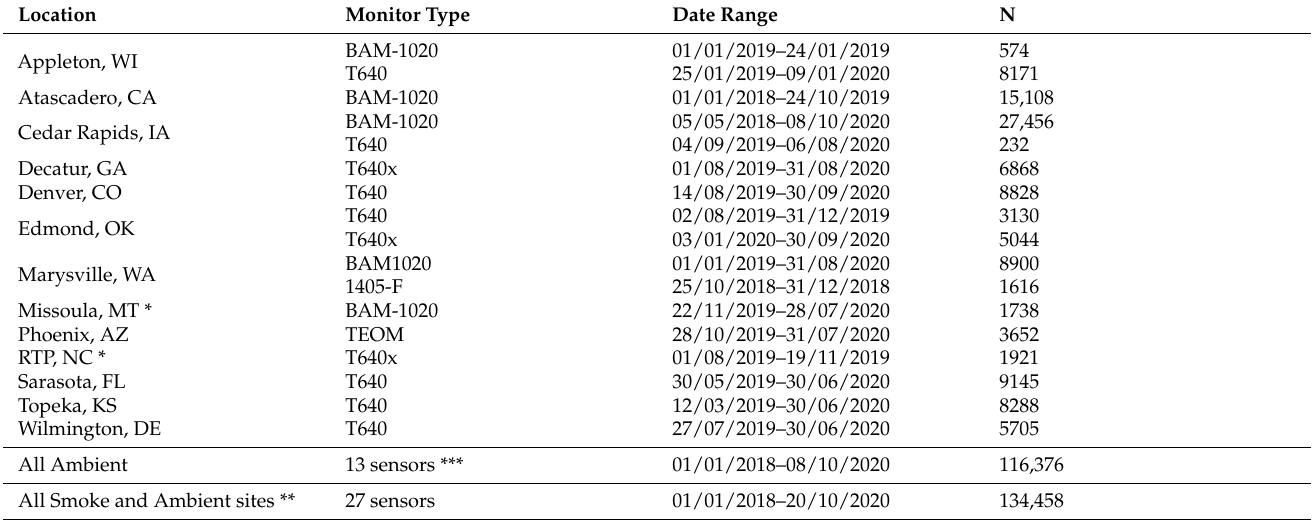
Table 1. Ambient summary of the hourly averaged typical ambient dataset locations, comparison monitor types, date ranges, and the number of data points (N). T640 and T640x data over 35 µ g/m 3 are excluded from this table and the analysis in the paper. All ambient sensors were collocated by the EPA or a